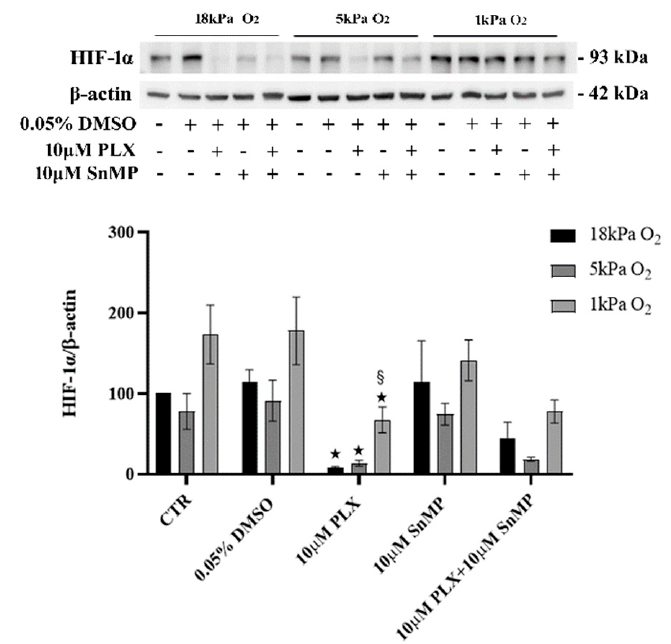
Figure 3. HIF-1 α protein levels in MeOV-1 cells adapted for 5 days to different O 2 levels. Immunoblot analysis of HIF-1 α protein expression in MeOV-1 cells cultured for 5 days under 18 kPa O 2 , 5 kPa O 2 or 1 kPa O 2 and then treated with 10 µ M PLX4032 (or 0.05% DMSO) and 10 µ M SnMP for 24 h under the same O 2 levels. β -actin was used as a loading control. Immunoblots are representative of 3 independent MeOV-1 cultures. Data denote mean ± S.E.M. (cid:70) p < 0.05 vs. respective CTR and DMSO; § p < 0.005 vs. PLX under 18 kPa and PLX under 5 kPa O 2 .